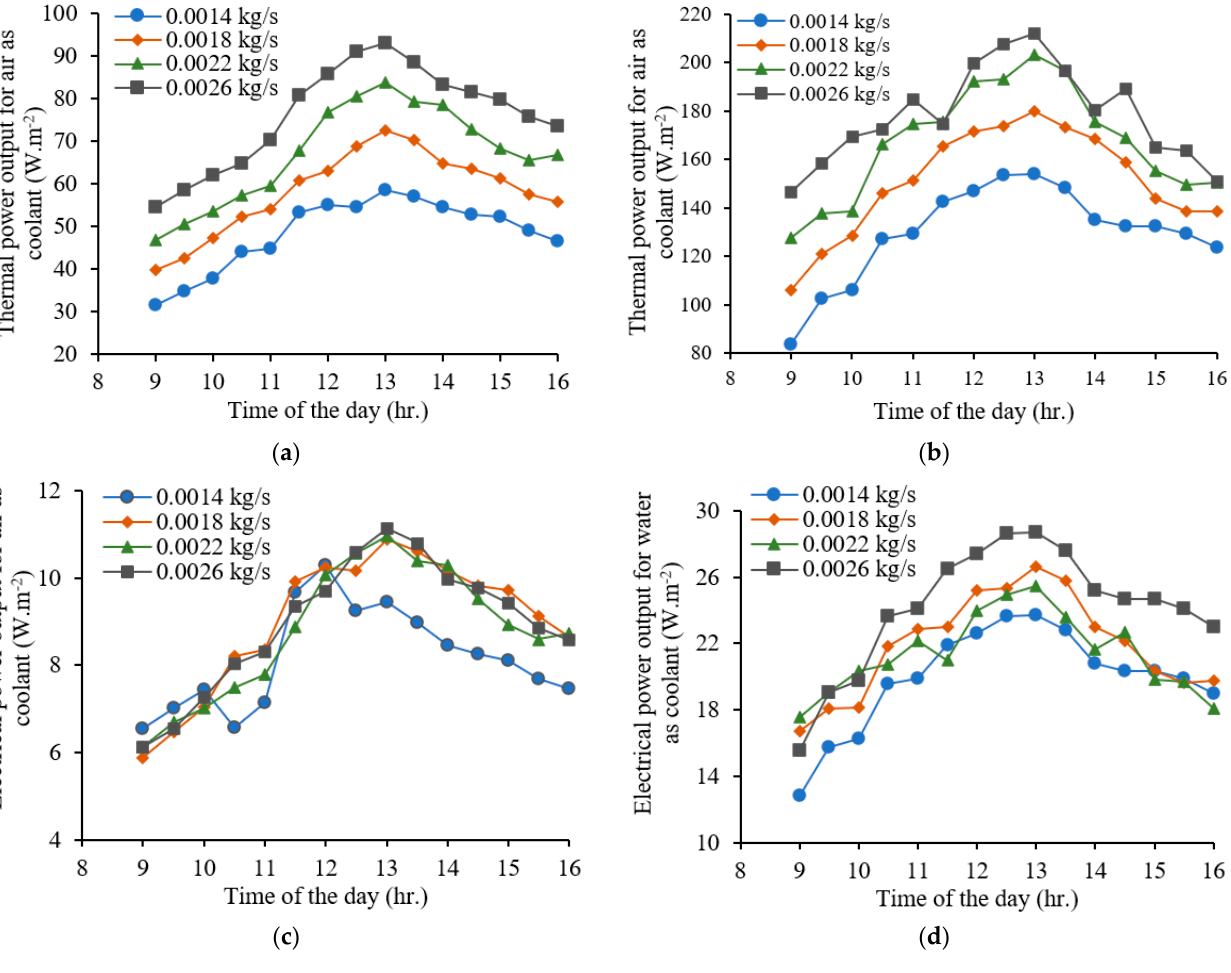
Figure 6. Thermal power output ( a ) for air as coolant, ( b ) for water as coolant; Electrical power output, ( c ) for air as coolant, and ( d ) for water as coolant.